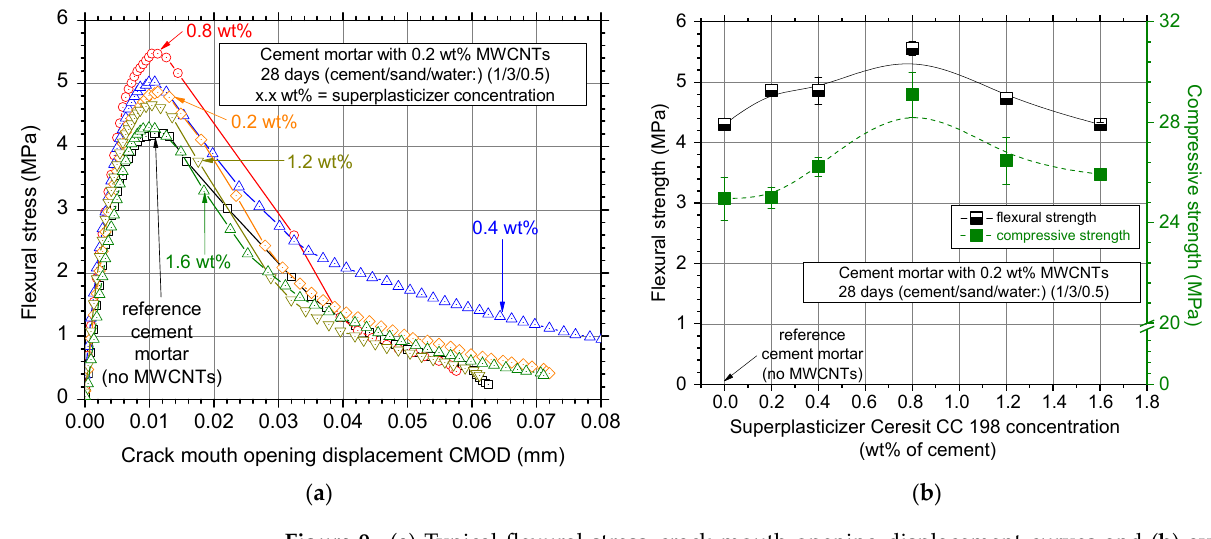
Figure 9. ( a ) Typical flexural stress–crack mouth opening displacement curves and ( b ) average flexural and compressive strength values and standard deviation of the nanocomposites dispersed with the Ceresit CC 198 surfactant at different concentrations.